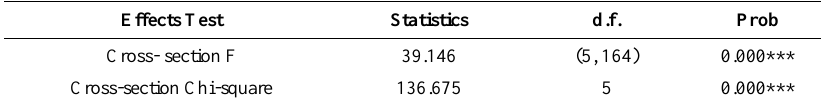
Table 4. Redundant Fixed Tests.